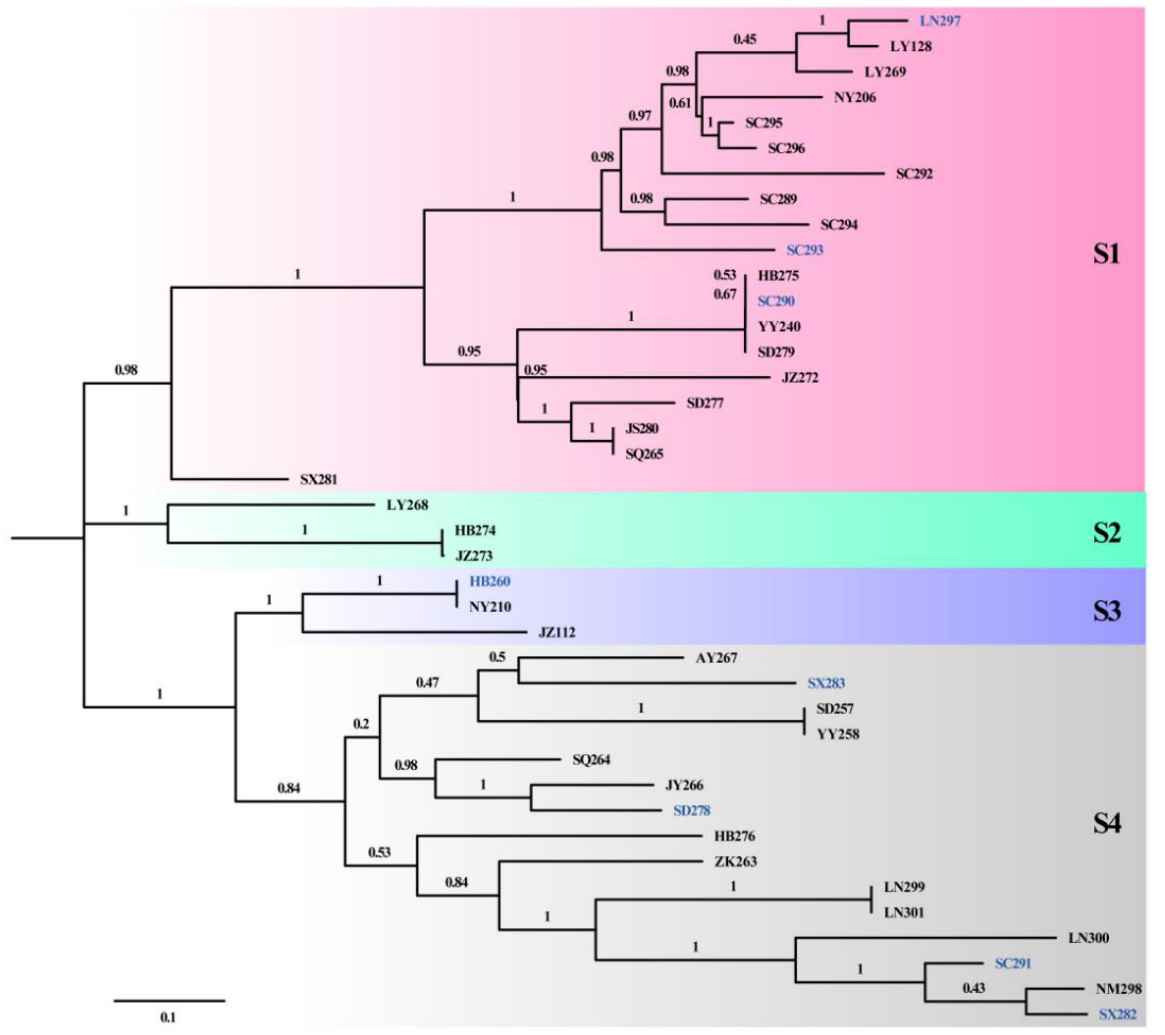
Figure 4. Phylogenetic analysis of D. arachidicola population with high-quality SNPs. The SNPs of 40 isolates were called by GATK based on the fact that the genome of isolate YY187 was selected as the reference, which caused the absence of isolate YY187 on the phylogenetic tree. The maximum likelihood (ML) tree was constructed using MEGA X with 1000 bootstrap replicates. The tree was visualized by modification in FigTree v1.4.4. Bootstrap values are shown above the branches. The sub-populations of D. arachidicola were classified and displayed by different colors. The isolates of B type are designated in blue font color.